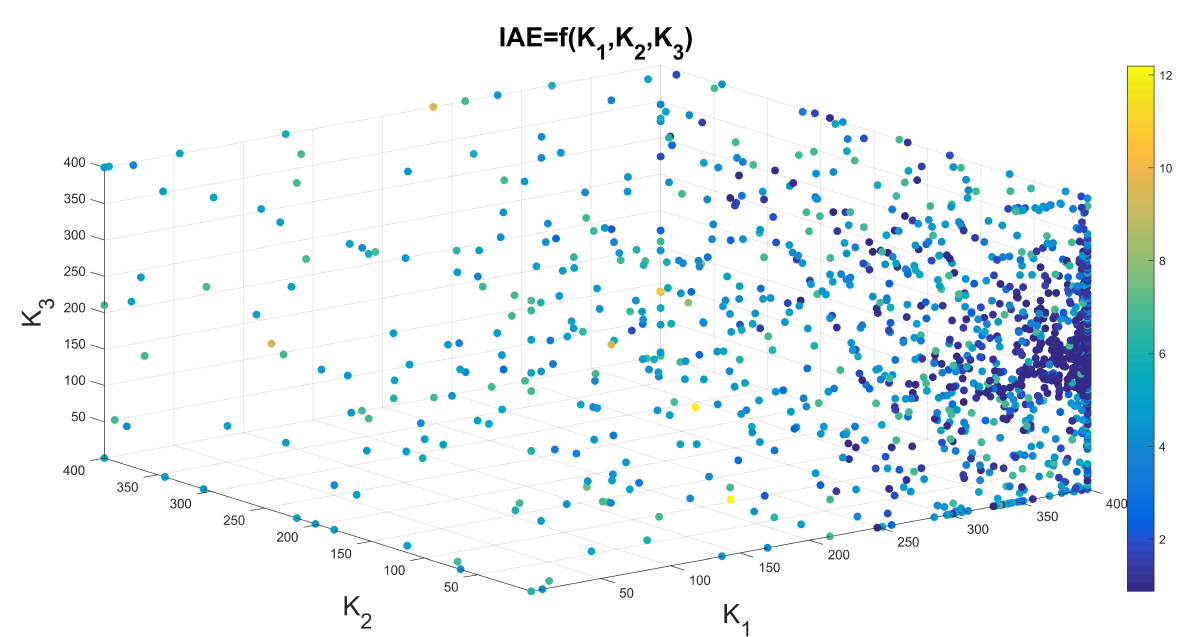
Figure 8. Experiment No. 2: Function IAE = f ( K i ) (for i = 1, . . . ,3).